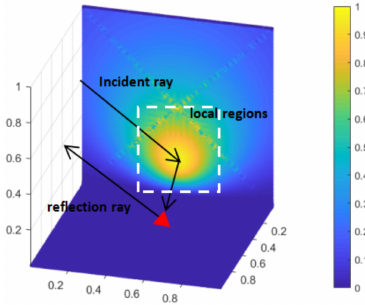
Figure 3. Normalized coupling intensity.